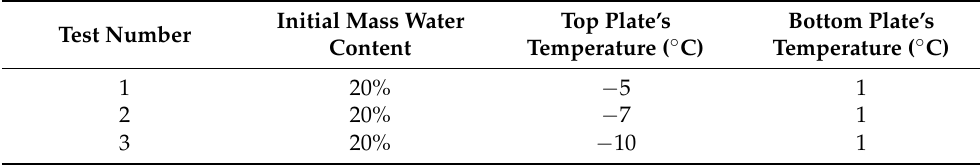
Table 2. Unidirectional freezing test